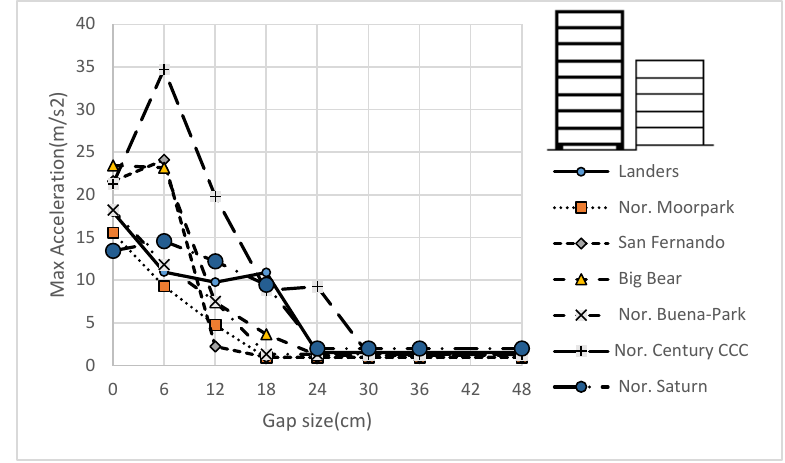
Figure 5. Peak accelerations of the 5th story of the base-isolated building with respect to different gap sizes for the third configuration under various earthquakes.